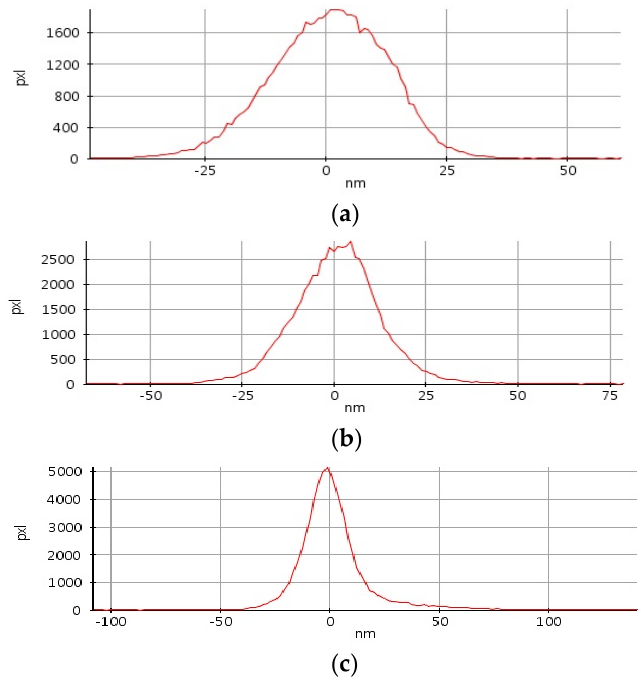
Figure 4. Histogram of the occurrence of irregularities on the surface of the deposited thin films after ( a ) 500, ( b ) 1000, and ( c ) 1500 cycles.